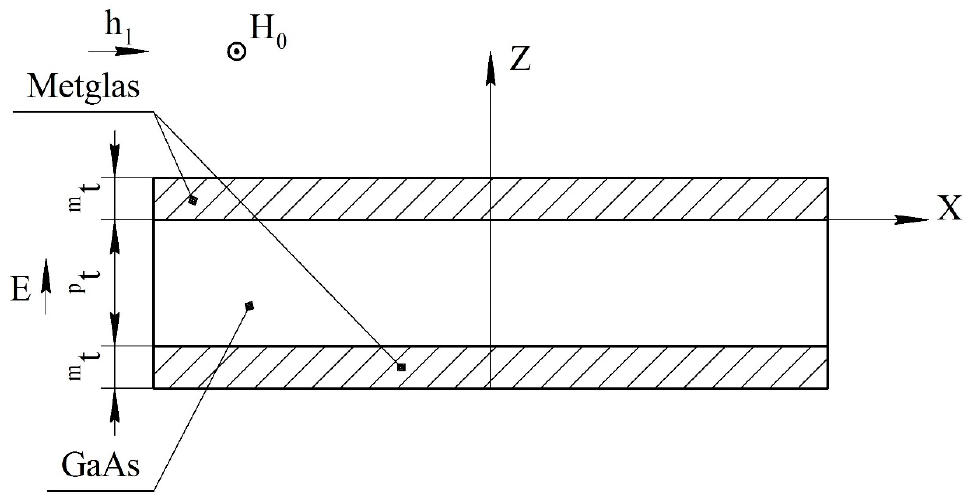
Figure 9. Symmetric tri-layer magnetoelectric composite for calculations of longitudinal-shear mode. In contrast to Figure 1, the magnetic fields are mutually perpendicular to each other.